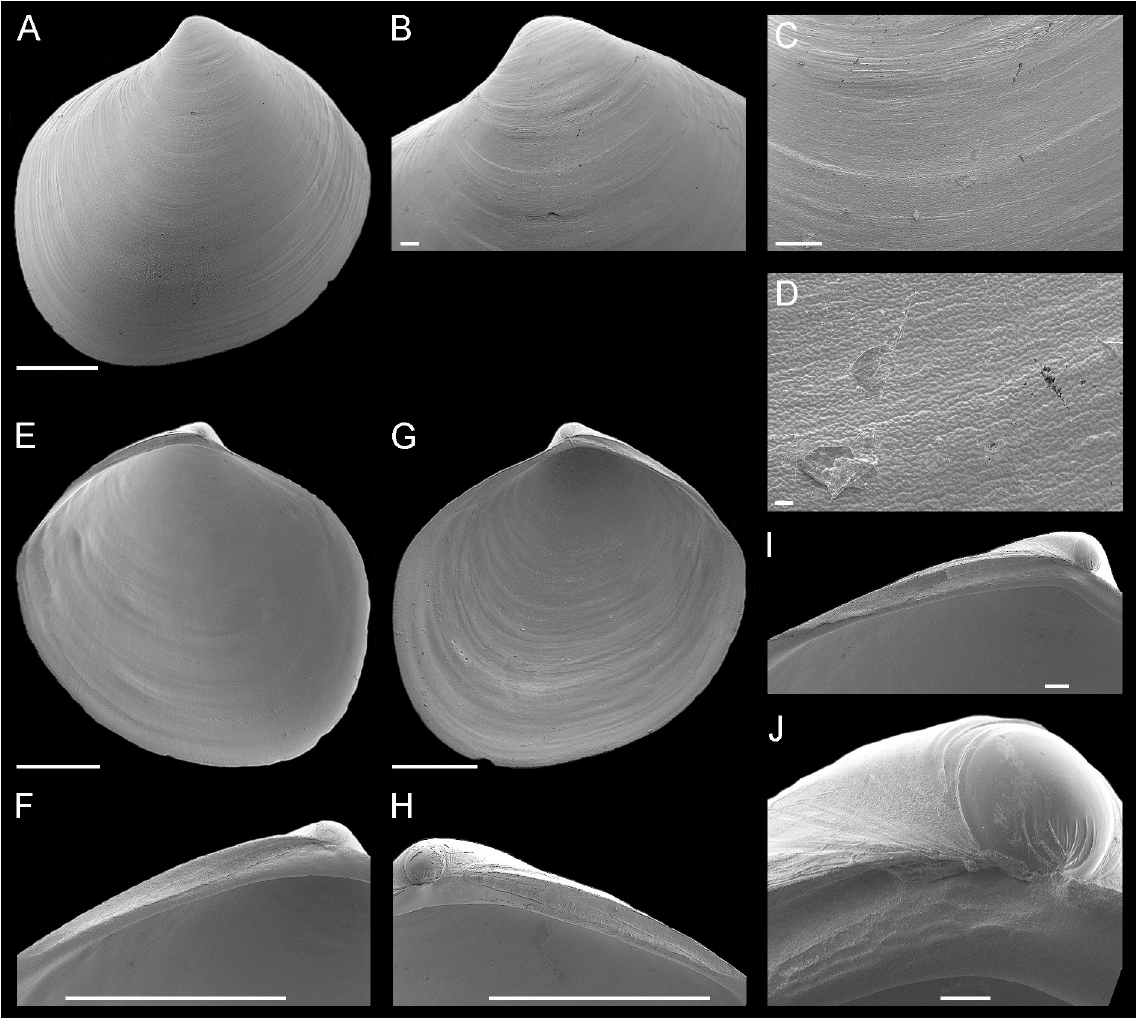
Fig. 14. Scanning electron micrographs of Thyasira kharkovensis sp. nov. (MIMB 43836). A . Exterior view of left valve. B . Sculpture of beak region. C–D . Sculpture of central shell part. E . Interior view of left valve. F . Hinge plate of left valve. G . Interior view of right valve. H . Hinge plate of right valve. I . Hinge plate of right valve with pits. J . Pits under beak of left valve. Scale bars: A, E–H = 1 mm; B–D, I = 100 µm; J = 50